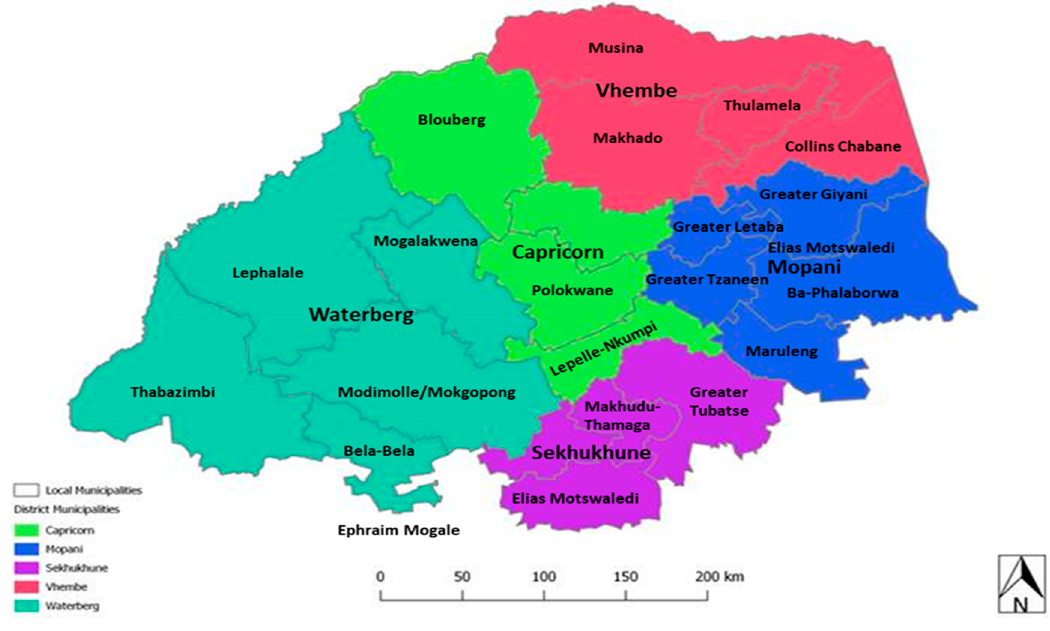
Figure 2. Map of the Limpopo Province showing the districts within the Province [25].